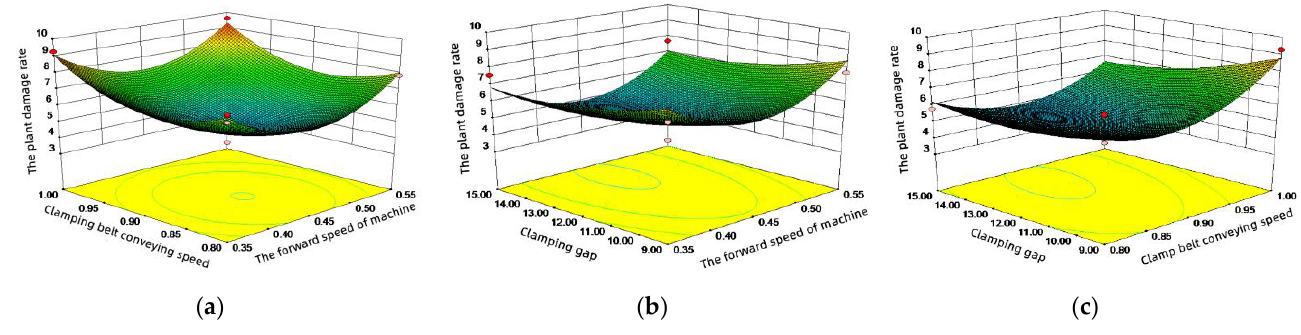
Figure 16. Effect of test factors on plant damage rate: ( a ) X 3 = 12 mm; ( b ) X 2 = 0.9 m/s; ( c ) X 1 = 0.45 m/s.